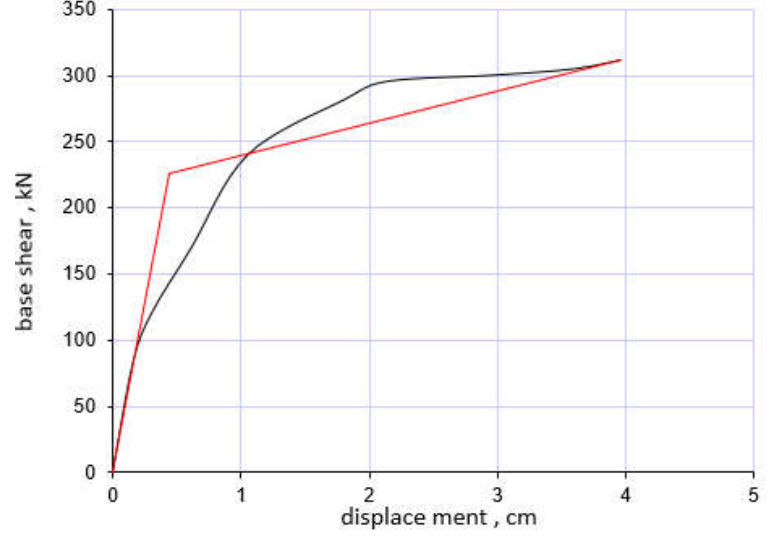
Figure 26. The hysteresis diagram due to loading on the frame. Figure 27 shows the two-line graph resulting from the cyclic load curve fitting.